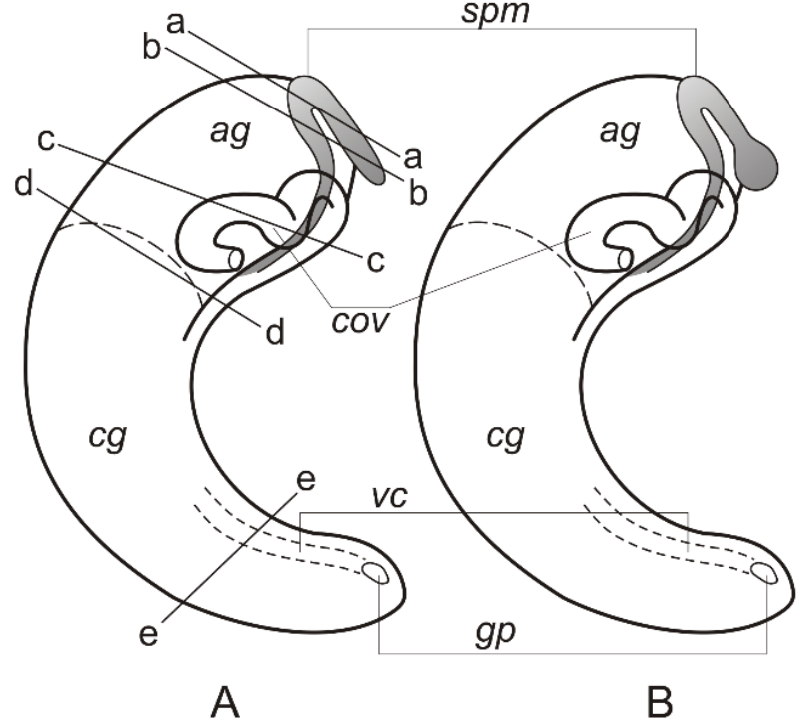
Figure 10. A scheme of the distal female genitalis of C. laevigata sp. n. ( A ) and C. knipowitschii ( B ) (ventral view of the oviduct and associated structures). Abbreviations: ag —albumen gland; cg —capsule gland; cov —coiled oviduct; gp —gonoporus; spm —spermatheca; vc —ventral channel of capsule gland. The histological sections of the C. laevigata sp. n. female genitals in positions a-a, b-b, c-c, d-d, and e-e are shown in Figure 11.